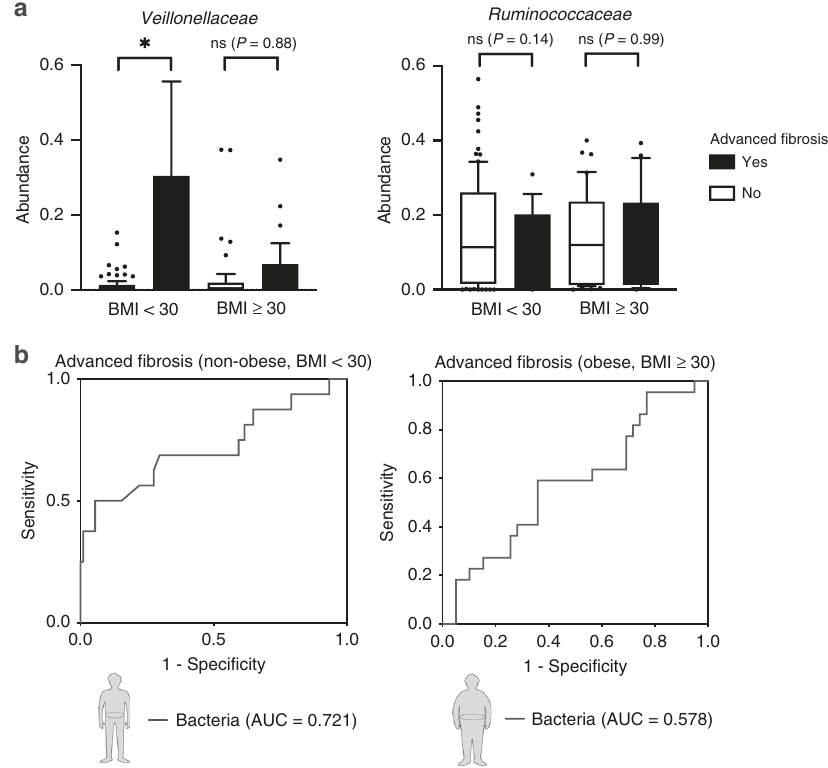
Fig. 6 Validation of gut-microbiome differences between non-obese and obese subjects using a Western NAFLD cohort. a Abundance of Veillonellaceae and Ruminococcaceae strati fi ed by obesity status and advanced fi brosis (* P = 0.0120, n = 107 for non-obese, and n = 61 for obese). b ROC curves using the combination of two selected bacteria ( Veillonellaceae and Ruminococcaceae ) were plotted for the diagnosis of advanced fi brosis in non-obese and obese subjects, and the areas under the ROC curve (AUCs) were calculated. The box plots indicate the median, 25th to 75th percentiles (boxes), and 10th to 90th percentiles (whiskers). Statistical analysis was performed using a two-sided Mann – Whitney test. * P < 0.05. ns, not signi fi